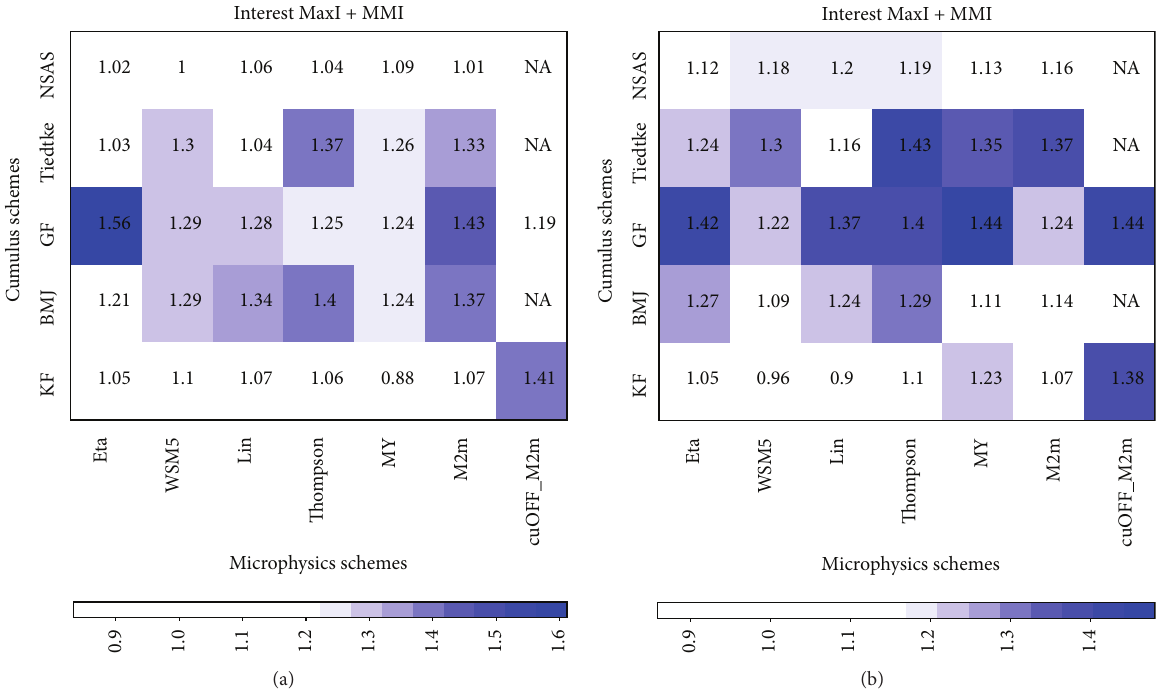
Figure 12: Maximum total interest plus median of maximum total interest distribution for each experiment using (a) thresholds of 0.5 mm and (b) 1.0 mm. Valid for 2000 UTC, 1 May 2012.